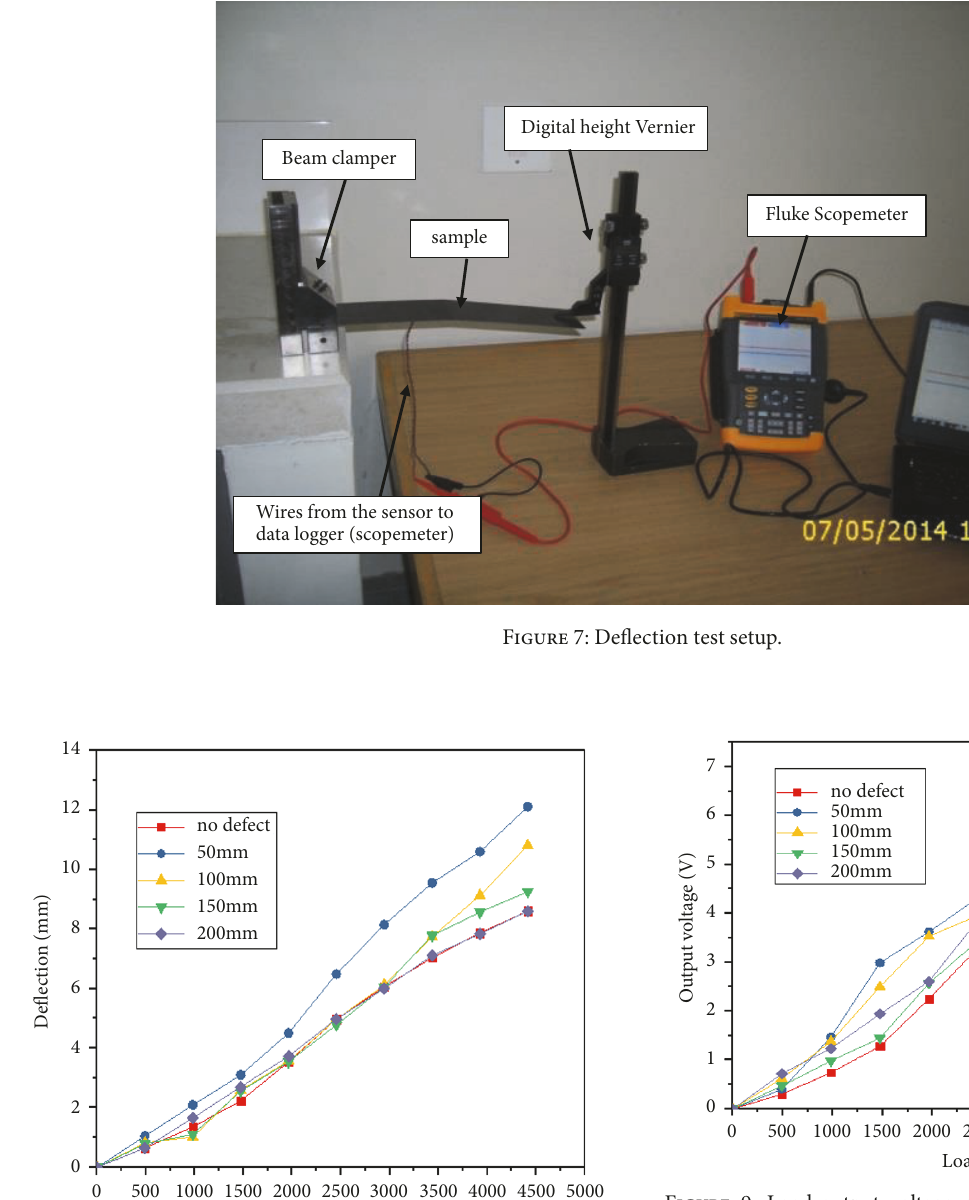
Figure 9: Load-output voltage curves for defect-free beam and beams with